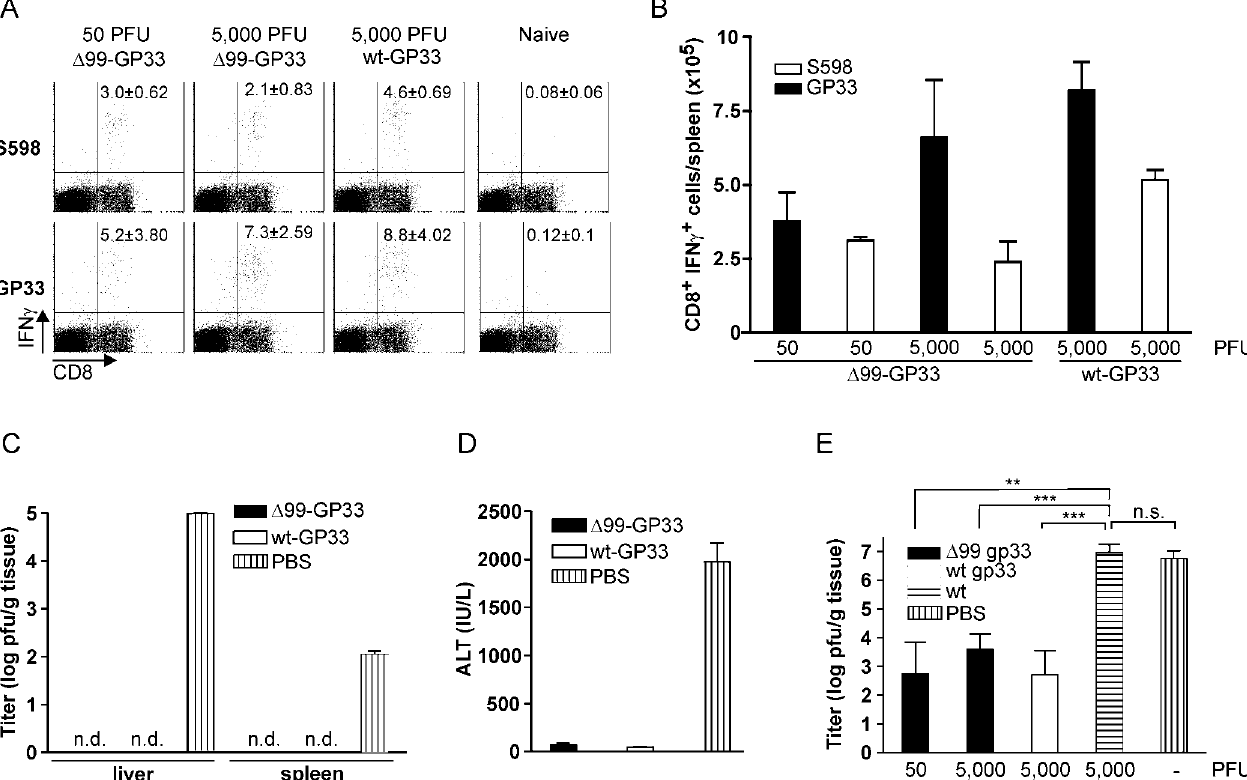
Figure 6. MHV-nsp1 D 99-GP33-GFP and MHV-GP33-GFP Elicit Strong CTL Responses and Protect Mice from Homologous and Heterologous Viral Infections (A, B) Groups of three C57BL/6 mice were immunized with the indicated doses of MHV-nsp1 D 99-GP33-GFP or MHV-GP33-GFP. IFN- c –secreting CD8 þ splenocytes were determined 8 d post immunization following short-term in vitro restimulation with GP33 or S598 peptide. Values in (A) represent the percentage 6 SD of IFN- c –secreting CD8 þ T cells restimulated with GP33 or S598; values in (B) represent the absolute numbers of CD8 þ IFN- c þ cells 6 SD ( n ¼ 6 for GP33, n ¼ 3 for S598). Pooled data from two separate experiments are shown. (C, D) Groups of three mice were immunized with 5,000 pfu of the indicated virus or PBS-treated and 14 d later challenged with 5,000 pfu of wild-type MHV-A59. At 5 d post challenge, viral titers in liver and spleen were determined (C) and ALT values (D) were measured. Data in graphs (C) and (D) represent means 6 SD from one representative experiment. n.d., not detected. (E) Protection against heterologous viral challenge. Groups of four C57BL/6 mice have been immunized with the indicated viral doses or PBS-treated and 28 d later challenged with 200 pfu of LCMV-WE. At 4 d post challenge, viral titers in spleens were determined. Data in graph represent means 6 SD from two pooled experiments with a total of eight mice per group. Statistical analysis was performed using Student’s t -test (***, p , 0.001; **, p ,